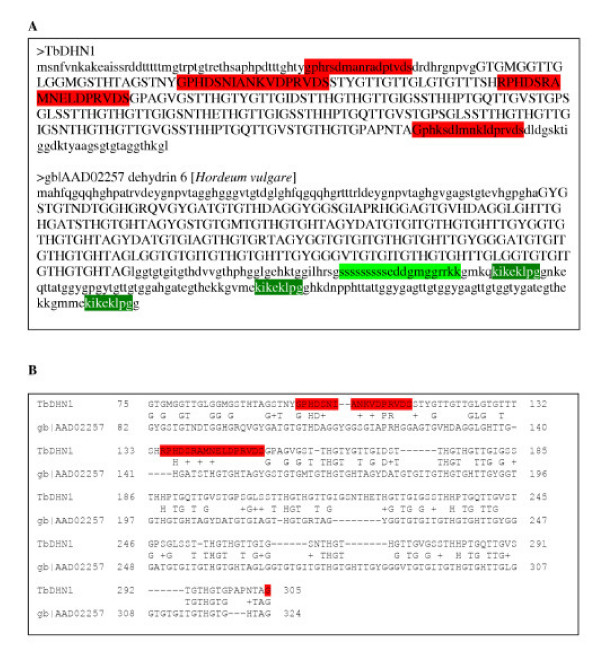
Panel A, TbDHN1 deduced amino acid sequence and dehydrin 6 from Hordeum vulgare. New CSPs of TbDHN1 (see text for description) [GenBank:DQ308610] are red background coloured; Prosite plant dehydrin signature patterns are green background coloured in dehydrin 6 [GenBank:AAD02257]: S-segment in light green and K-segments in dark green. Sequence fragments aligned by blastx are in upper cases (see panel B). Panel B, Basic local alignment between TbDHN1 and dehydrin 6 from Hordeum vulgare. The best basic local alignment (E-value = 4e-25) was built by blastx between amino acids 75 and 305 of TbDHN1 and amino acids 82 and 324 of dehydrin 6 [GenBank:AAD02257]. New CSPs of TbDHN1 are red background coloured.